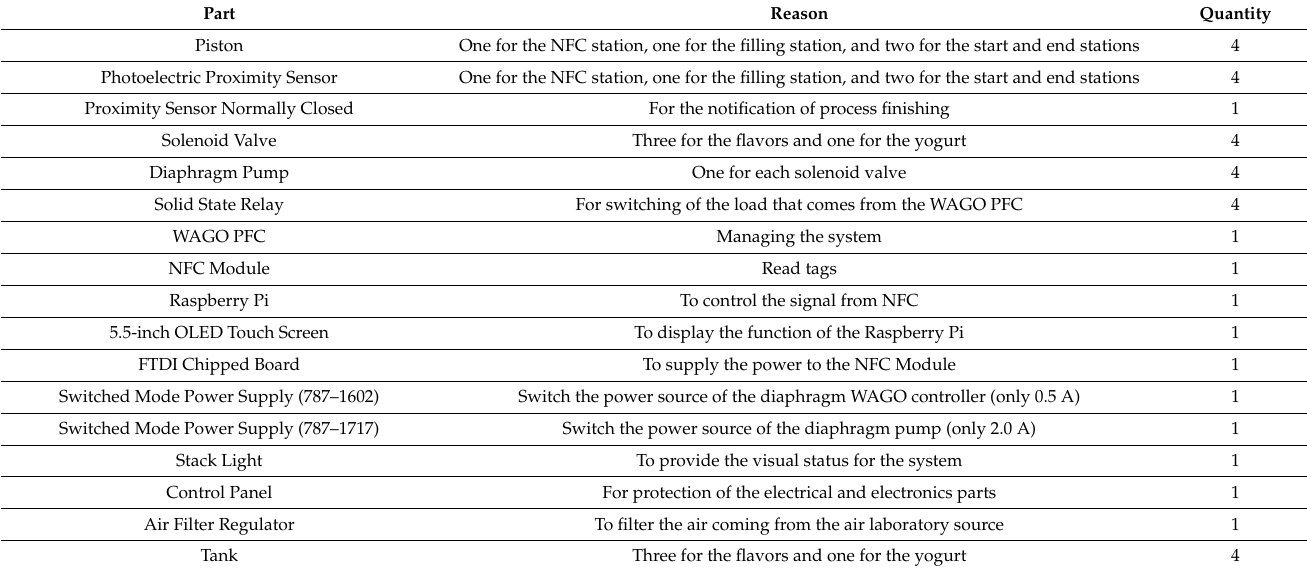
Table 1. Major parts used in the automatic yogurt filling